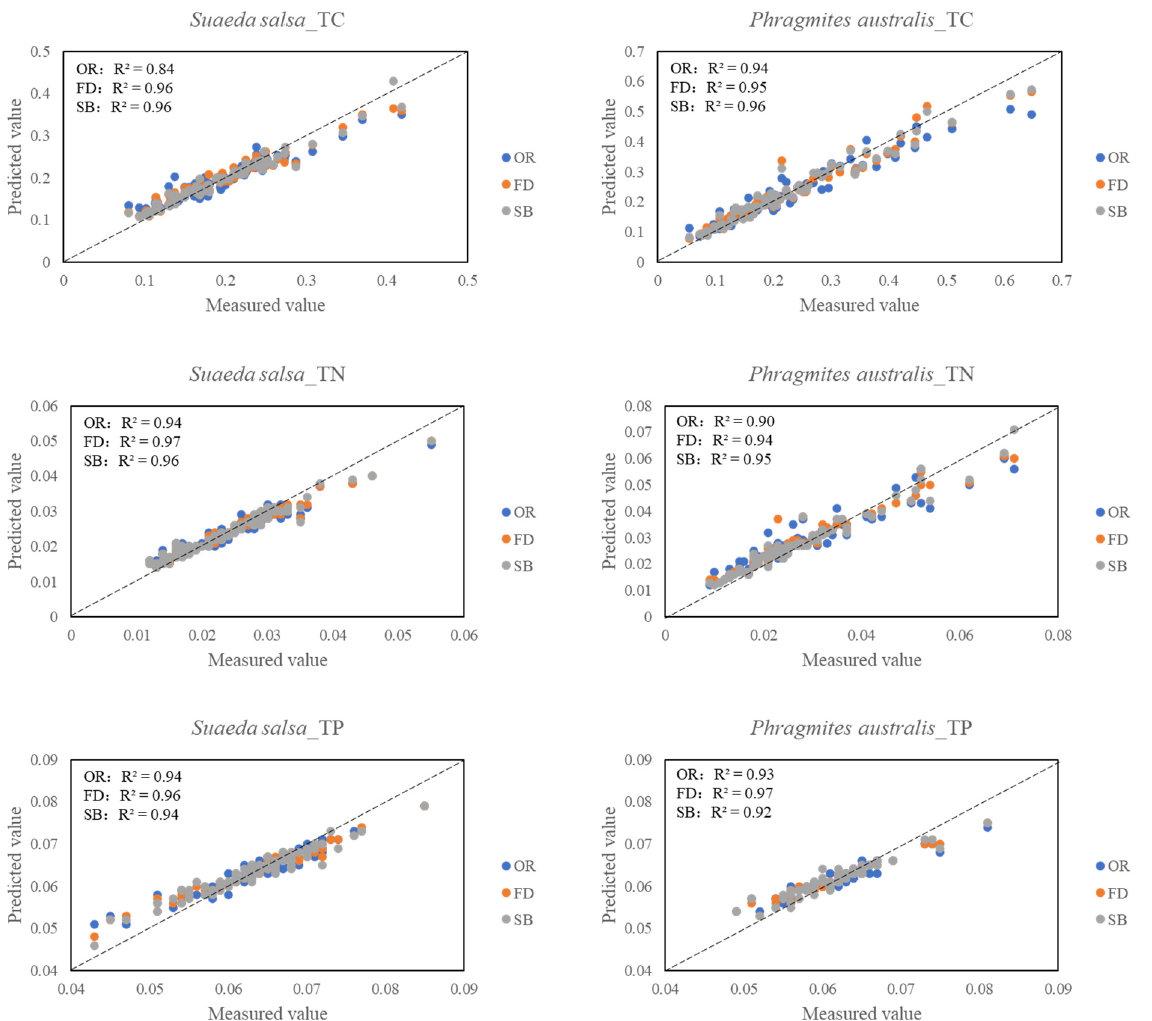
Figure 6. RF modelling results for P. australis and S. salsa . OR: original reflectance; FD: first derivative reflectance; SB: sensitive band.